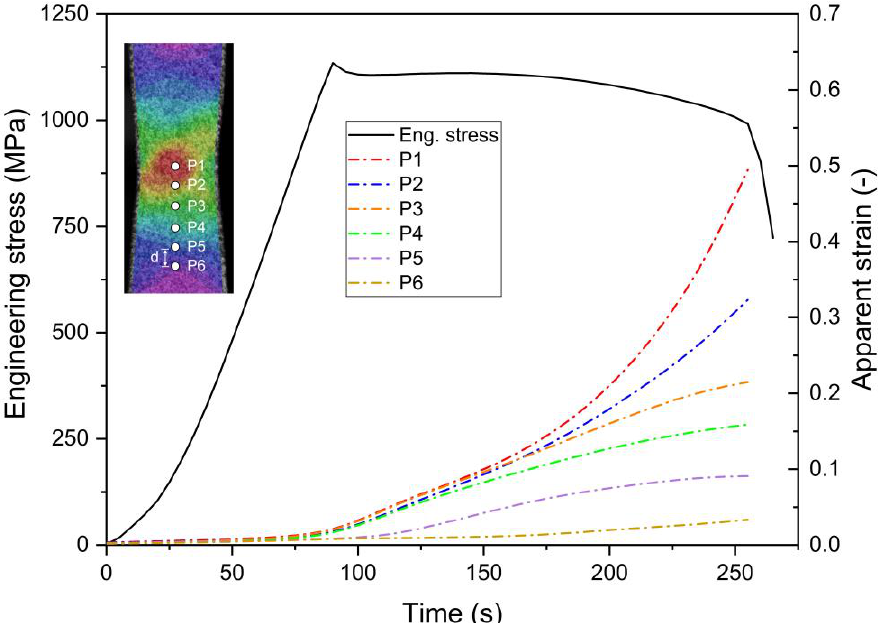
Figure 7. Loading curve of uniaxial tensile test and the evolution of the apparent strain at different positions (P1 – P6) on the sample surface.